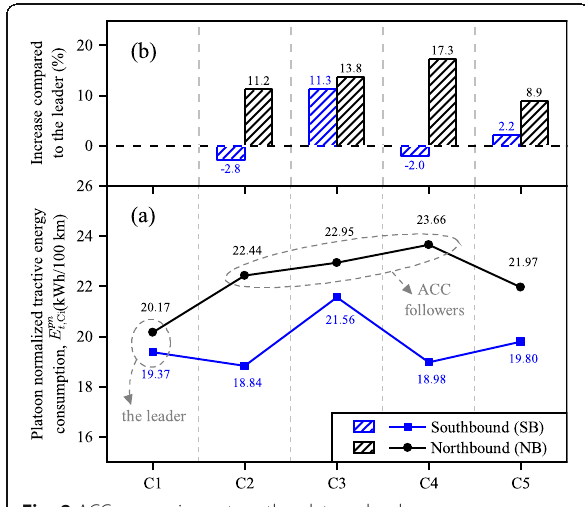
Fig. 8 ACC energy impact on the platoon